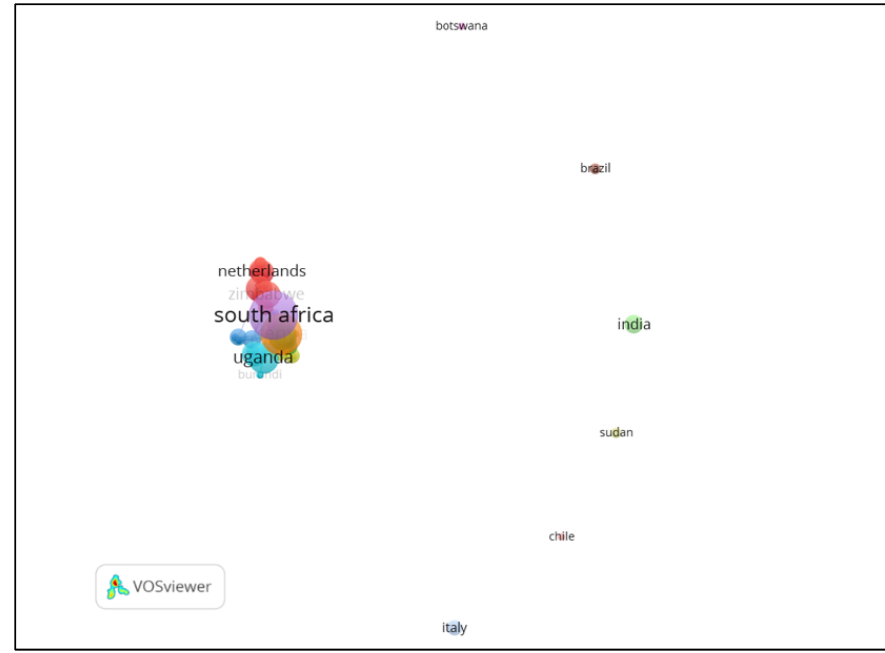
Figure 6. Output of country co-authorship on edible insects in Africa.